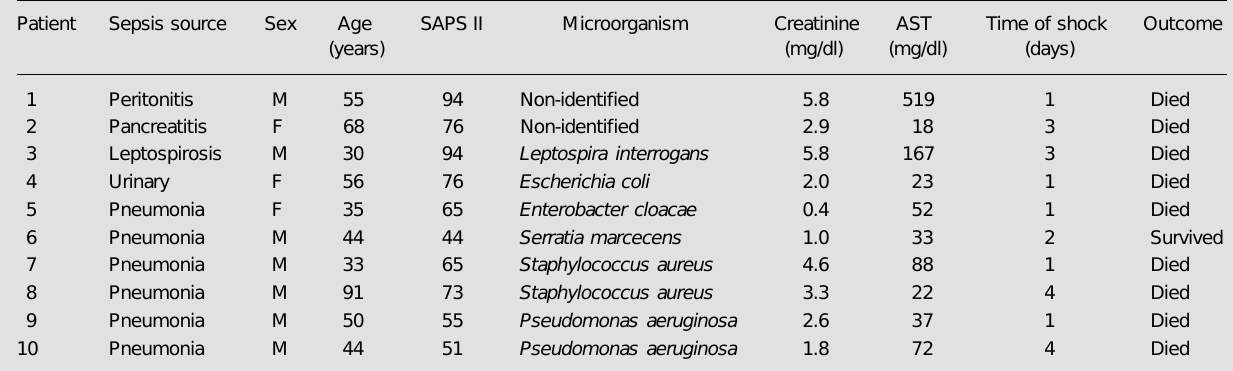
Table 1 - Patient characteristics. SAPS, Simplified acute physiology score; M, male; F, female; AST, aspartate aminotransferase.